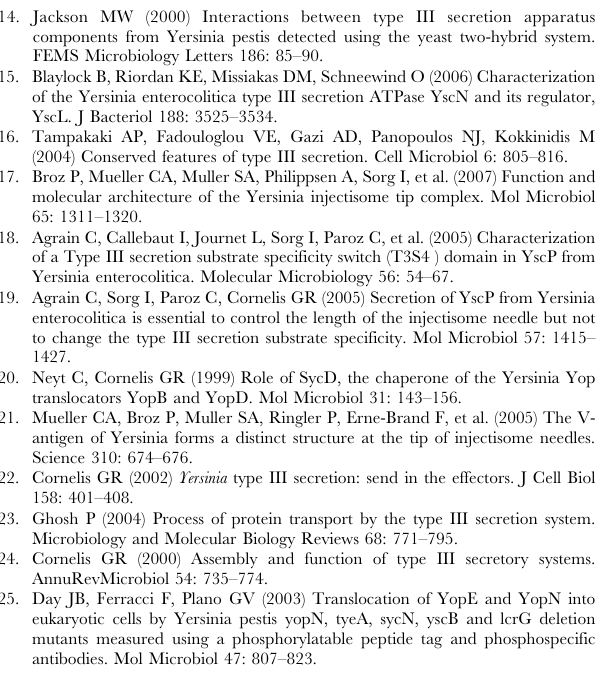
Figure S1 Mutation of YpCD1.09 gene does not influence the LCR. Table S1 57 target genes encoded in pCD1 plasmid according to the genome annotation of Y. pestis CO92. Table S2 Known interactions of Y. pestis T3SS compo- nents reported in literatures. Table S3 List of 19 Y. pestis T3SS proteins that were successfully cloned or expressed in this study. Table S4 Twelve novel interactions identified in this study and the validation results by GST pull down assay were